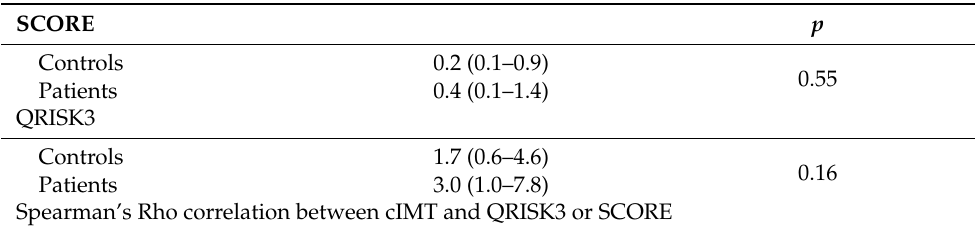
Table 2. Relationship of QRISK3 and SCORE with subclinical carotid atherosclerosis in patients and